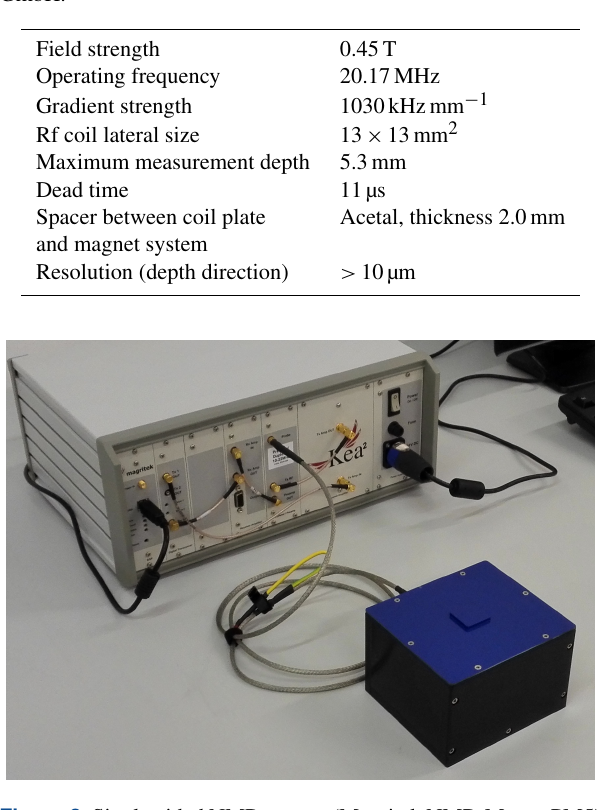
Figure 2. Single-sided NMR system (Magritek NMR-Mouse PM5) and spectrometer Kea 2 .